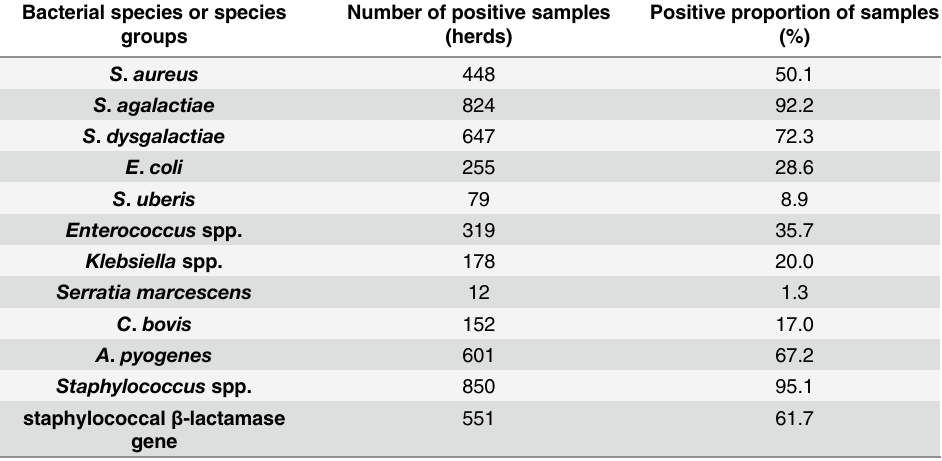
Table 1. Proportion of 894 bulk milk samples that were positive for bovine mastitis pathogens in China from April 2012 to October 2013. Bacterial species or species Number of positive samples Positive proportion of samples groups (herds)